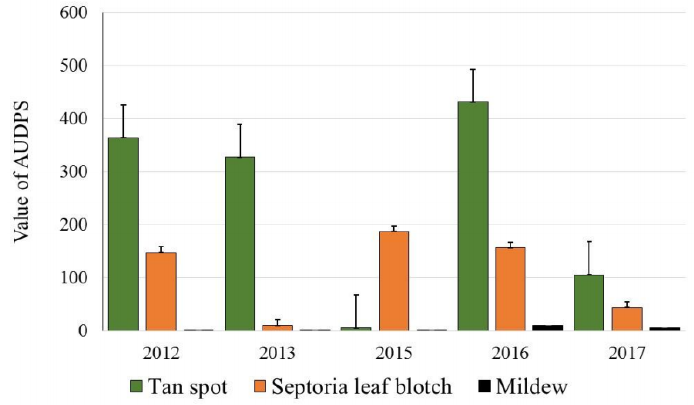
Figure 1. Development of winter wheat leaf diseases depending on year (average data).